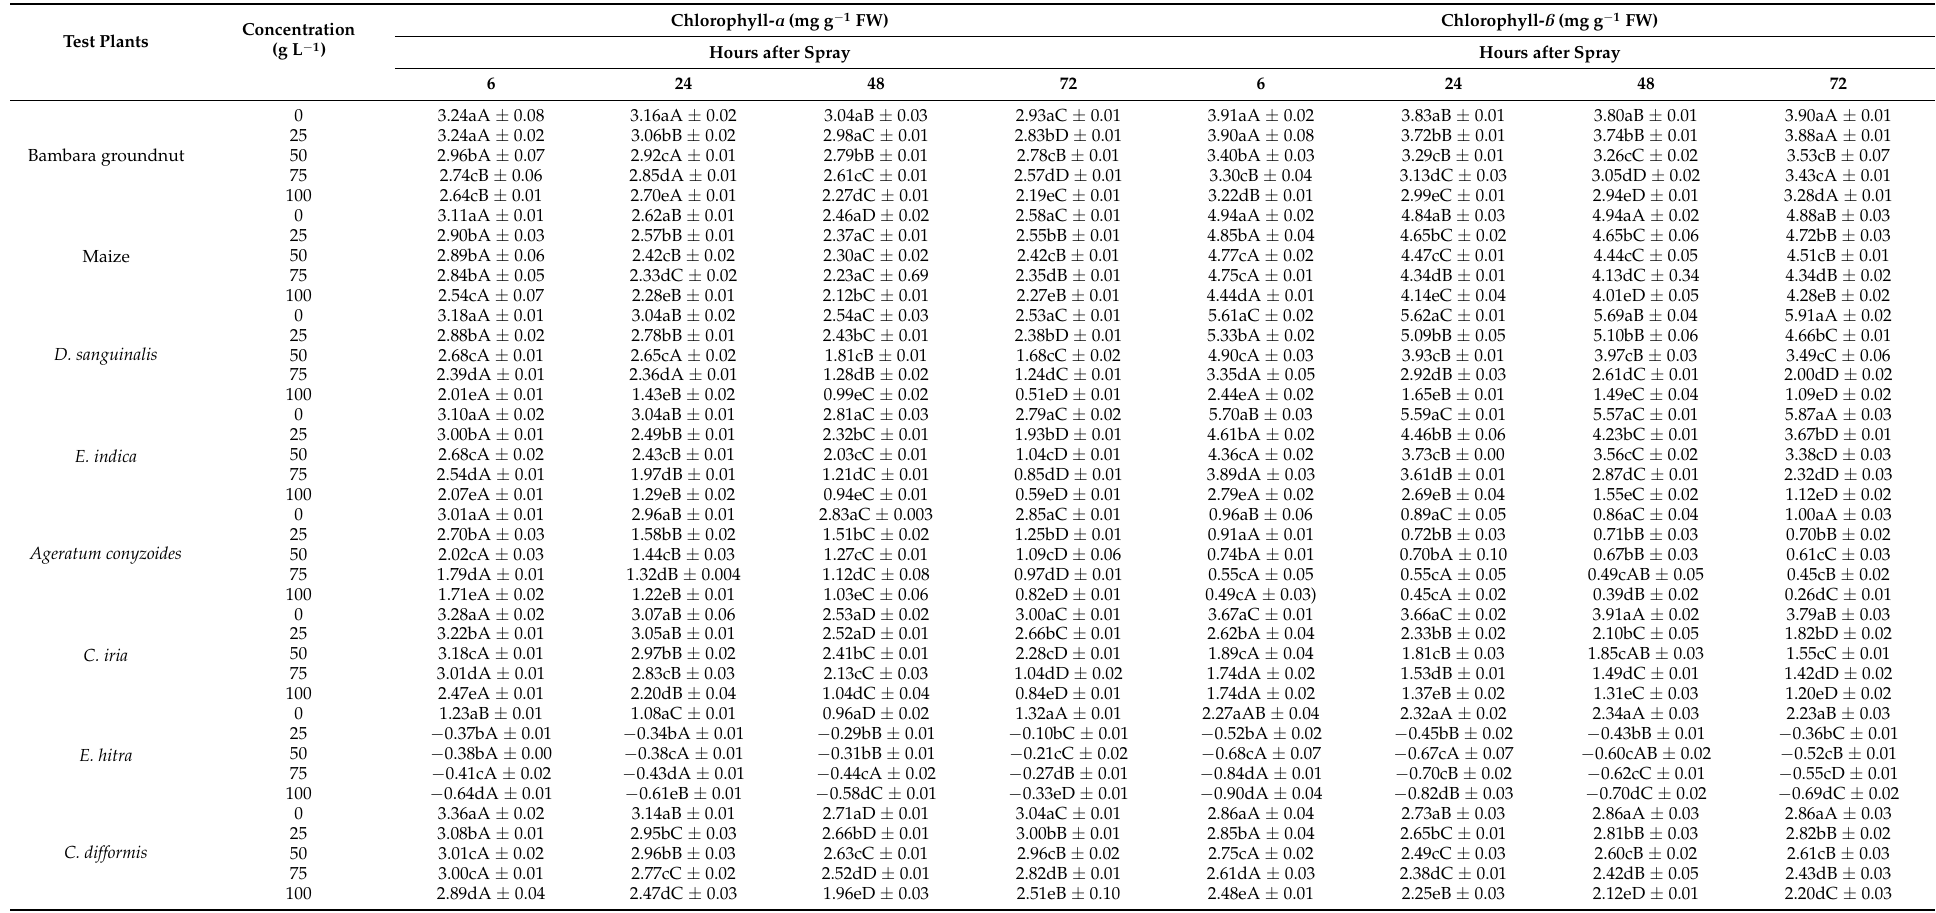
Table 3. Response of chlorophyll- A and chlorophyll- á content due to the foliar spray of P. hysterophorus leaf extract on several crops and